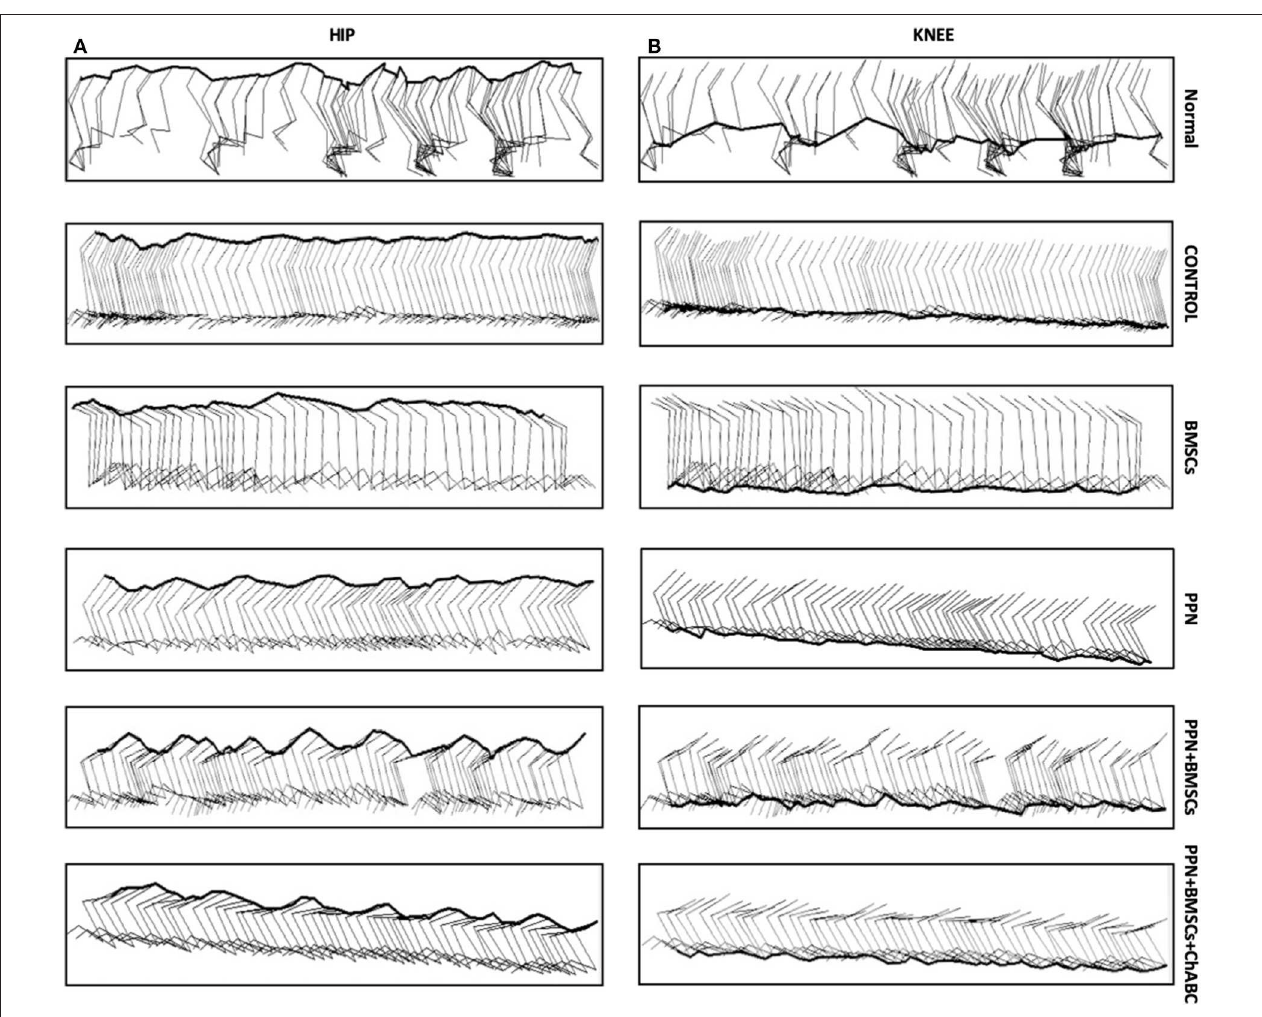
FIGURE 7 | Representative sagittal stick diagrams of kinematic gait recording. (A) Hip; (B) knee. Diagrams in intact rats show the movement of the hips and knees is in waveforms. In the control groups, diagrams show no movements; only flat lines can be seen. In the group treated with BMSC, waves are inconsistent and have small amplitude. With PPN treatment, there is an increase in the formation of waves in both joints. Noticeably, in the combined treatment (PPN + BMSCs and PPN + BMSCs + ChABC) groups, the waves show greater amplitude and are constant in both joints. The images of Normal, Control, PPN, PPN + BMSCs, and PPN + BMSCs + ChABC represent the right leg, and only the group for BMSCs represents the left